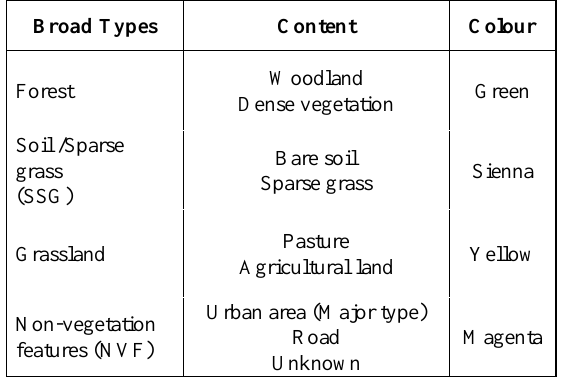
Figure 2 The result of principal component analysis; left: TM; right ：